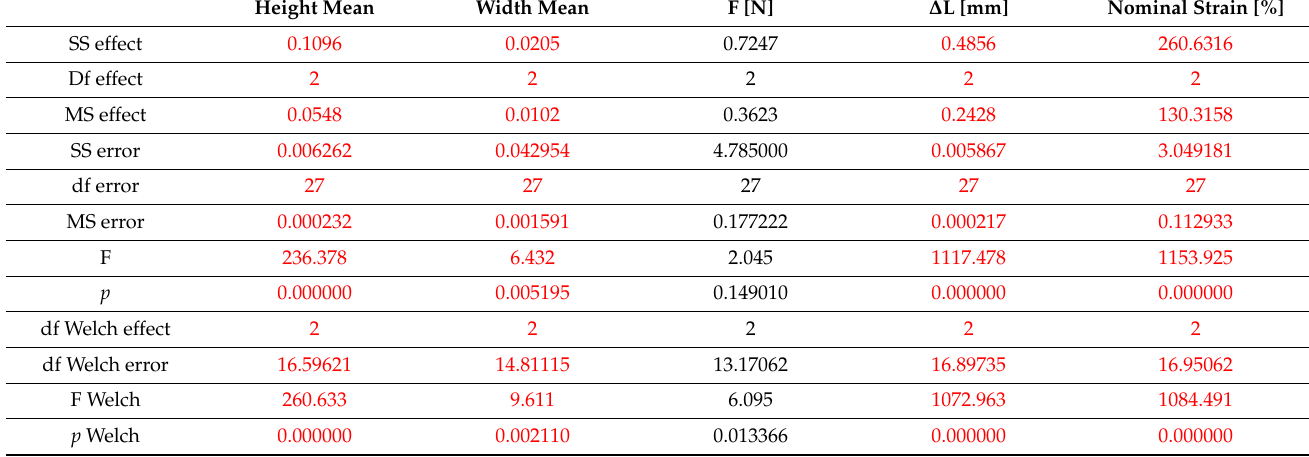
Table 5. Variance analysis (the statistical signi fi cance for p < 0.05 was presented in red). Height Mean Width Mean